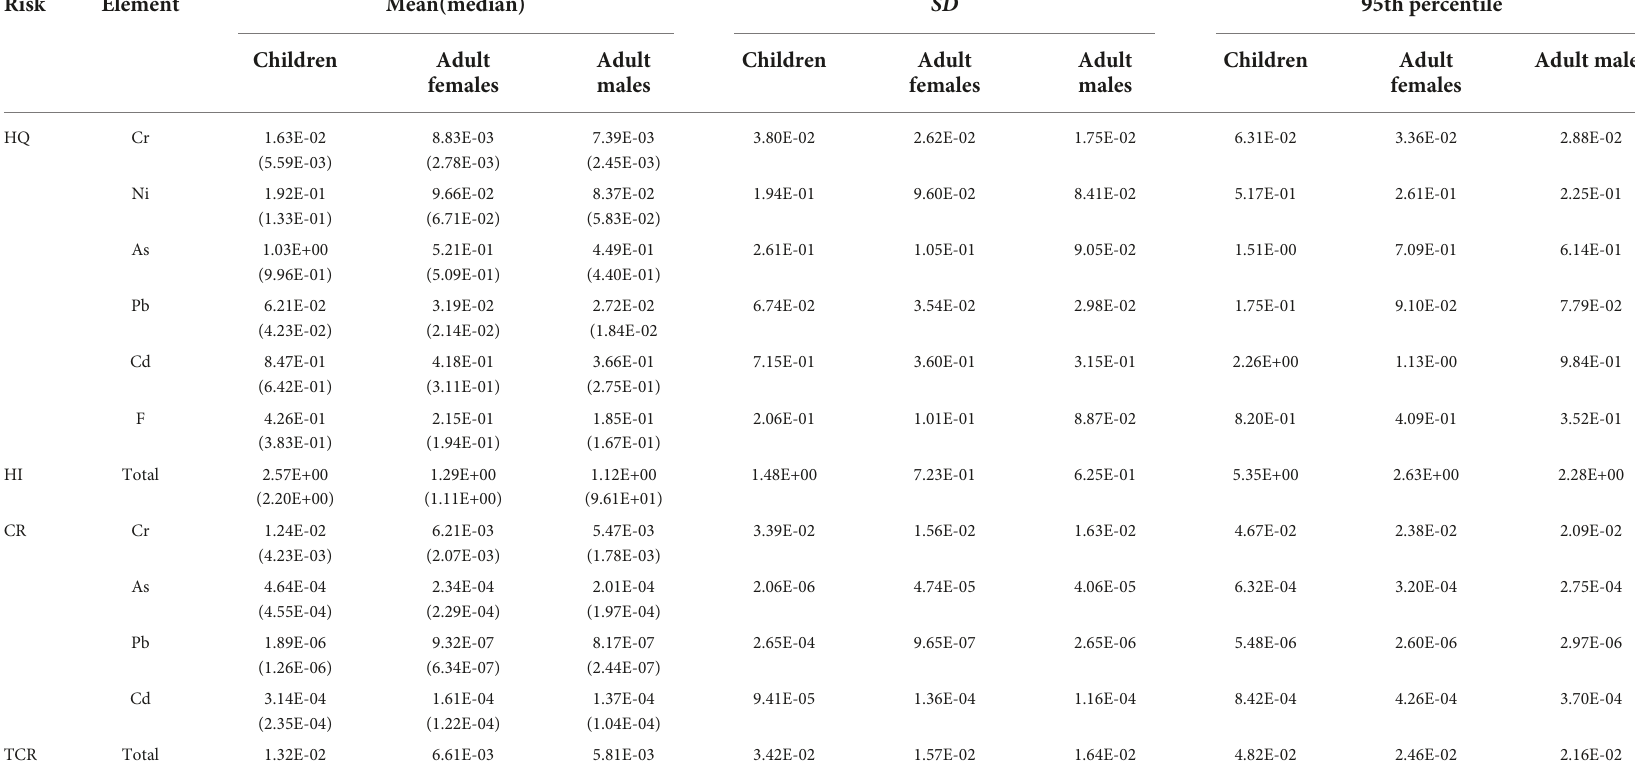
TABLE 3 Probabilistic evaluations of non-carcinogenic and carcinogenic risks for the PTE in wheat grains.